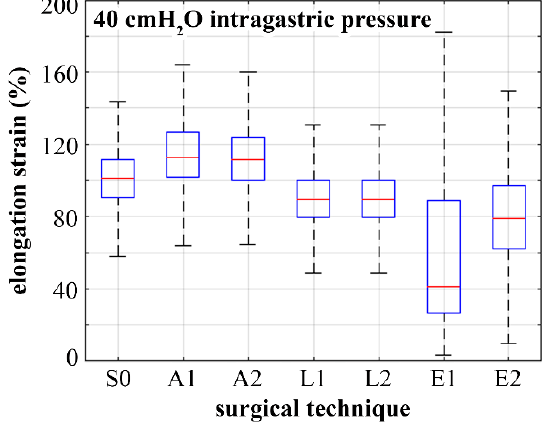
Figure 7. Box plots representing the distribution of stomach distension as tissue elongation strain within the overall stomach wall: comparison of results for the physiological stomach (S0), laparoscopic adjustable gastric banding (A1, A2), laparoscopic sleeve gastrectomy (L1, L2), and endoscopic sleeve gastroplasty (E1, E2).